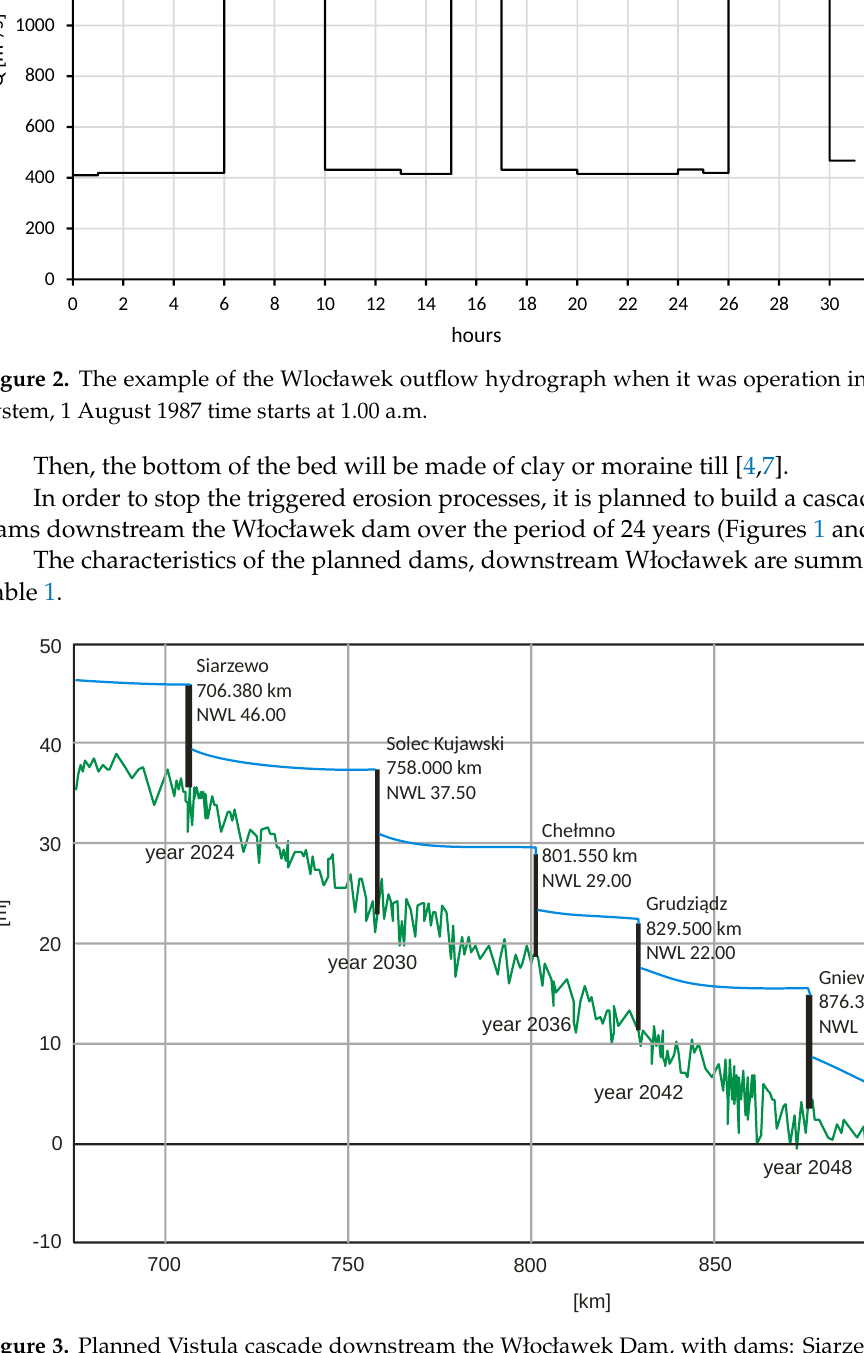
Figure 3. Planned Vistula cascade downstream the Włocławek Dam, with dams: Siarzewo, Solec Kujawski, Chełmno, Grudzi ˛ac and Gniew (commissioning year given in the Figure); NWL—normal water level, black lines—dam locations, blue line—water levels, green line—minimum bed